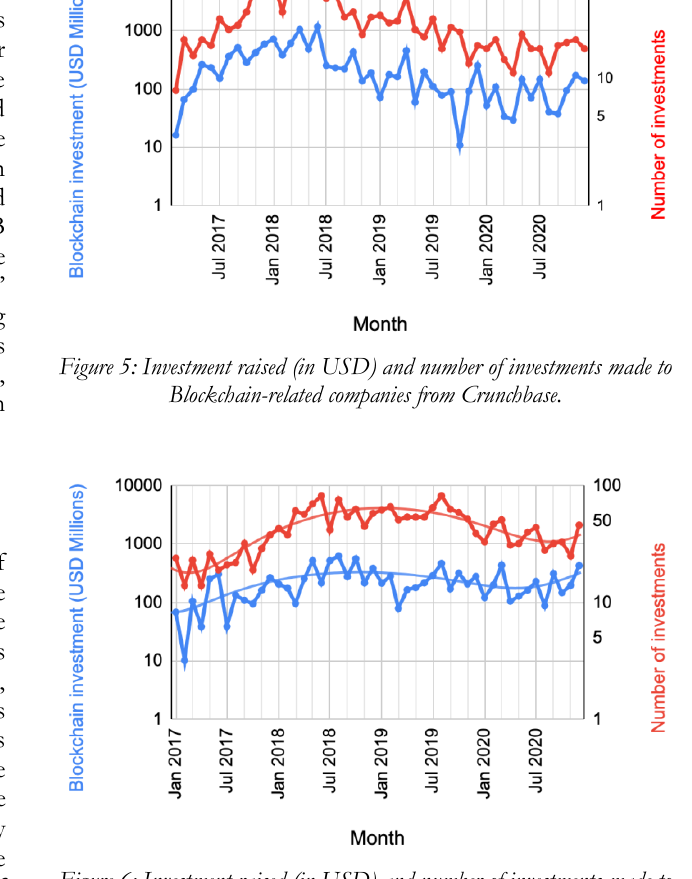
Figure 6: Investment raised (in USD) and number of investments made to Blockchain-related companies from CB